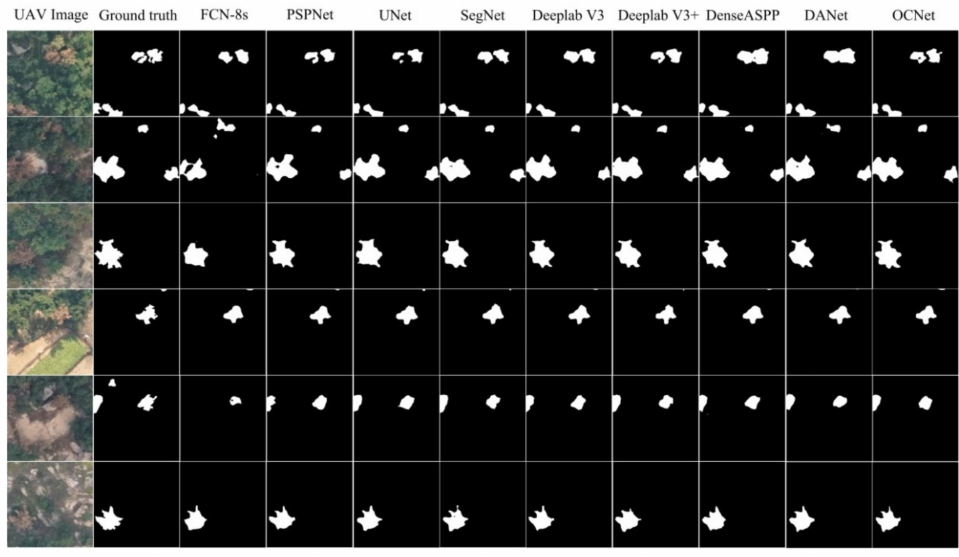
Figure 5. Segmentation results of models using focal